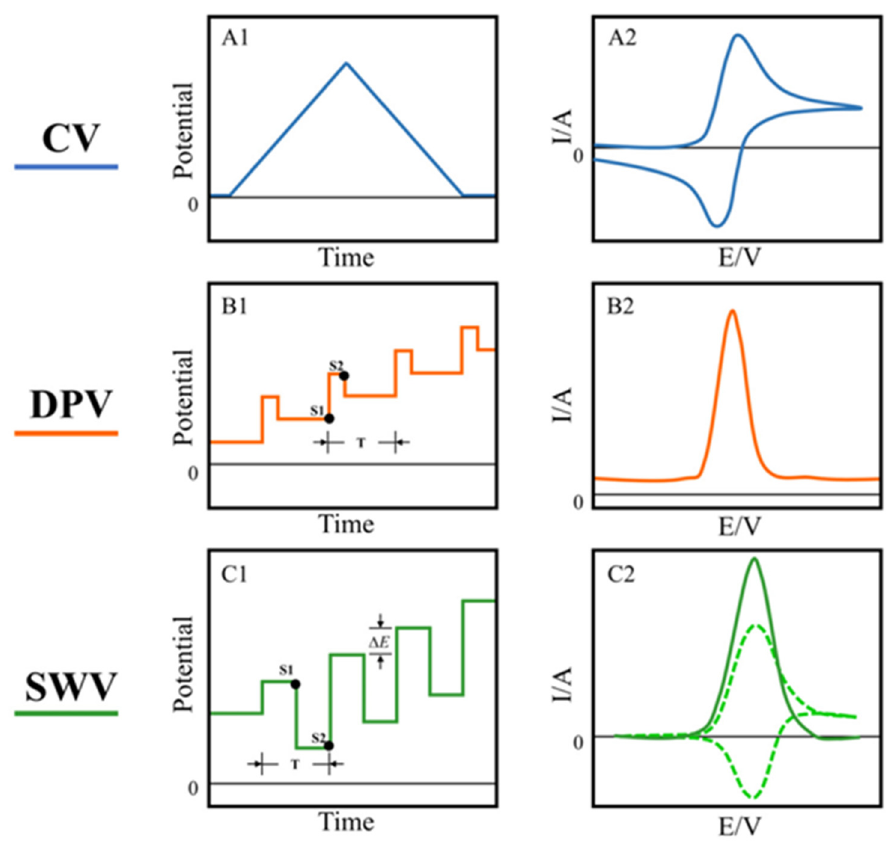
Figure 2. The potential ( A1 ) and typical response current ( A2 ) of CV; the potential waveform ( B1 ) and voltammogram ( B2 ) of DPV. In the potential waveform, T is the waveform period, and S1 and S2 are the two current sampling points; the typical potential waveform ( C1 ) of SWV, ∆ E is the potential increment, T is the potential period. The response current consists of forward (anodic current) and reverse (cathodic current) components (dashed line in ( C2 )), and their difference results in a net current (solid line in ( C2 ). Reproduced from Ref. [22]. Licensee 2022 MDPI.